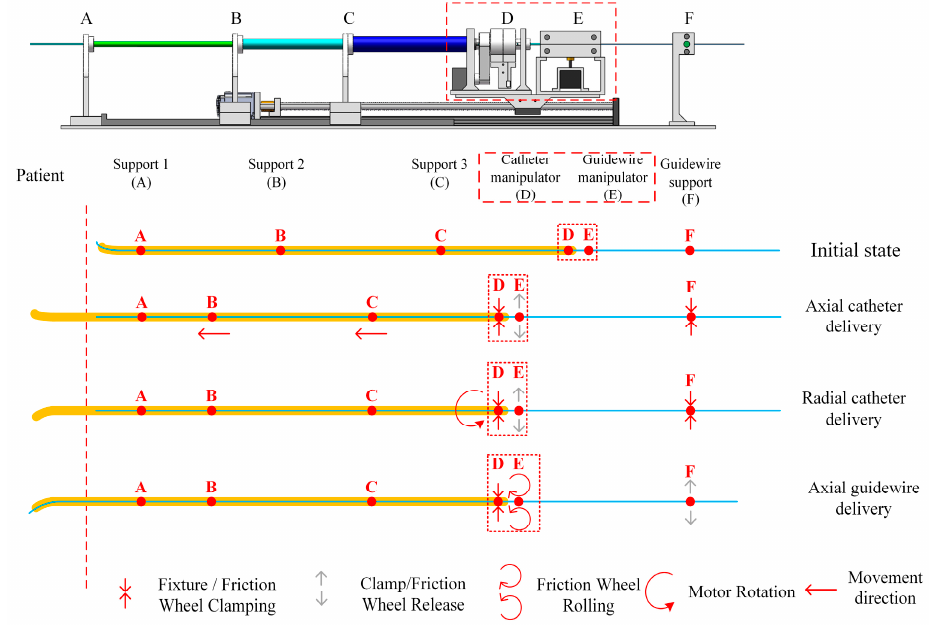
Figure 12. Catheter/guidewire cooperative